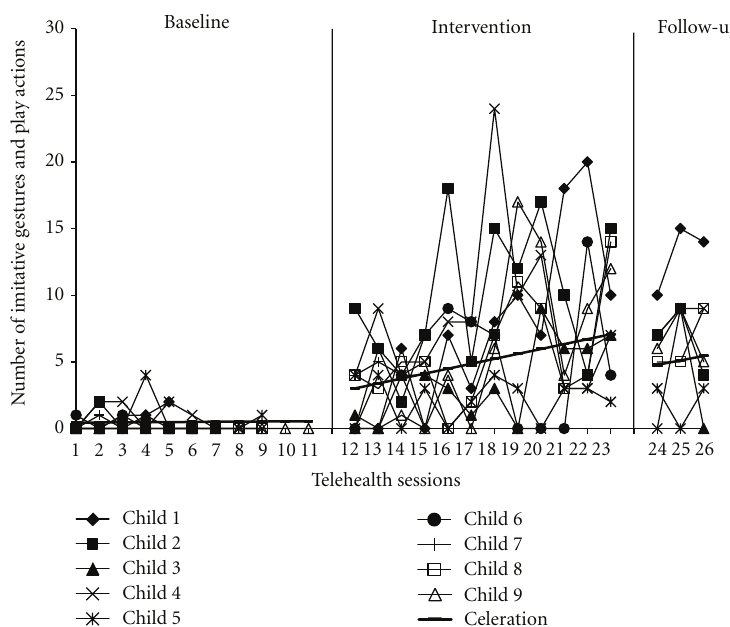
Figure 4: Individual child spontaneous imitative